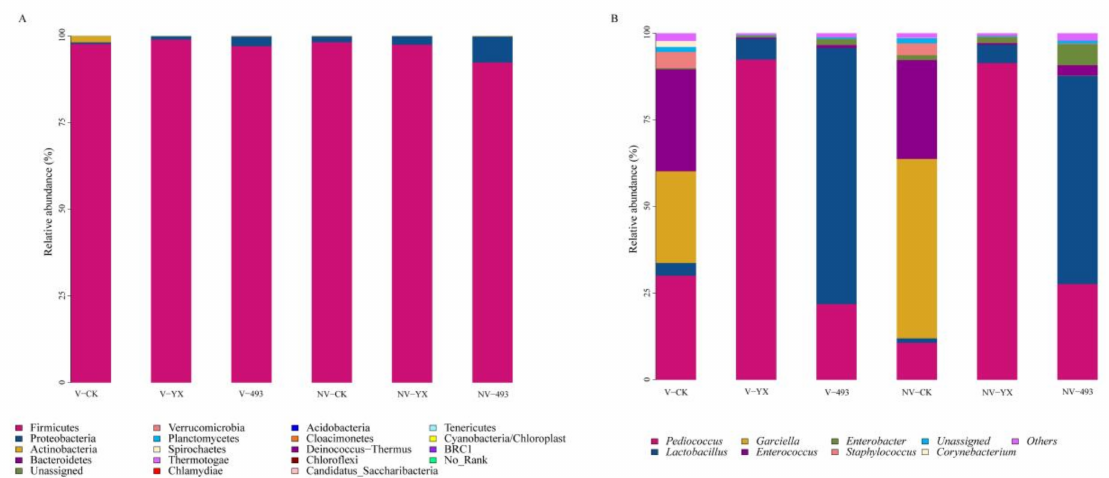
Figure 2. Relative abundance of bacteria at phylum ( A ) level and genus ( B ) level of alfalfa after 90 days of ensiling. Control, CK; vacuum treatment, V; inoculated with YX, YX; inoculated with Lactobacillus plantarum ZZUA493, 493; nonvacuum treatment, NV.